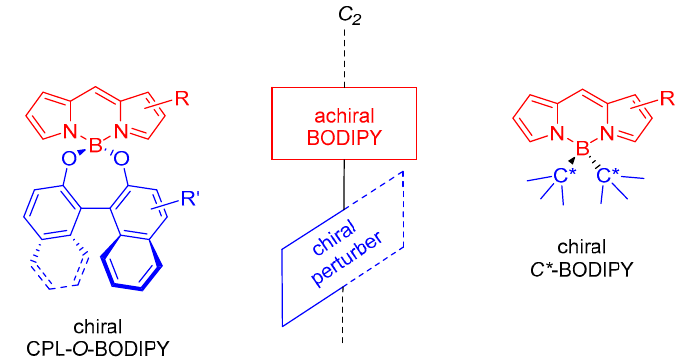
Figure 2. Chiral CPL- O -BODIPY vs. chiral C*